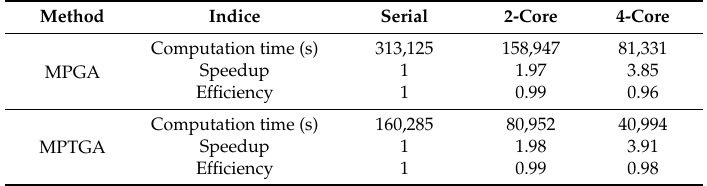
Table 4. Serial and parallel results of a multi ‐ core parallel genetic algorithm (MPGA) and MPTGA. Method